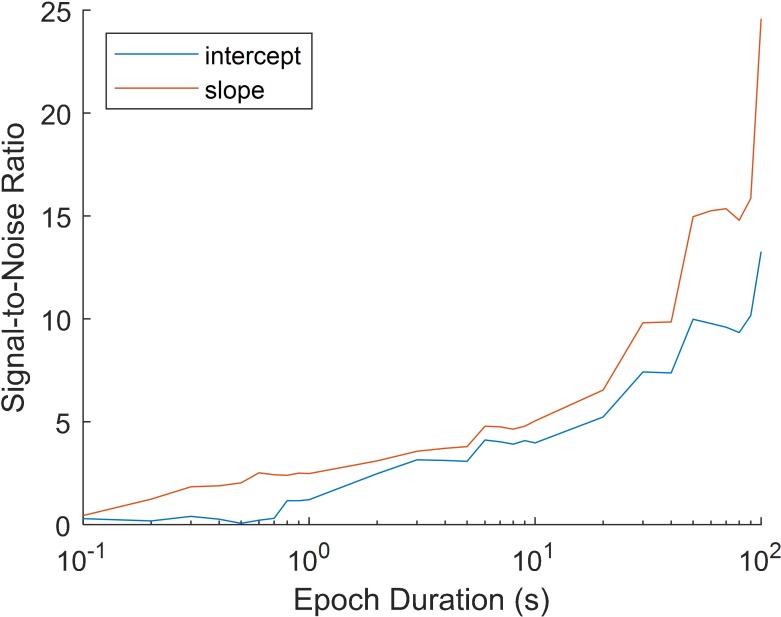
The simulated impact of epoch duration on the estimate of the 1/f curve.Fractal signal was generated using the Neuro Digital Signal Processing Toolbox (Cole et al., 2019; https://github.com/neurodsp-tools/neurodsp) for epochs with a duration of 0.1 s to 100 s (this was repeated 1000 times for each time bin). IRASA was used to convert the resulting time-series into their fractal power spectrum. The intercept and slope of the fractal curve was then estimated as described in the Materials and methods section. Signal-to-noise was calculated for each epoch duration by dividing the mean slope estimate (across 1000 repetitions) by the standard deviation across estimates. A low signal-to-noise ratio indicates that estimates were not consistent across repetitions, while a high signal-to-noise ratio indicates high consistency across repetitions. The simulation demonstrates that short epochs (<1 s) produce highly unreliable estimates of the slope. Longer epochs (>30 s) produce a more reliable estimate. While long epochs are infeasible in event-related designs, averaging over trials (as in the EEG analysis of Figure 4—figure supplement 4) may help approximate the estimates of longer epochs.